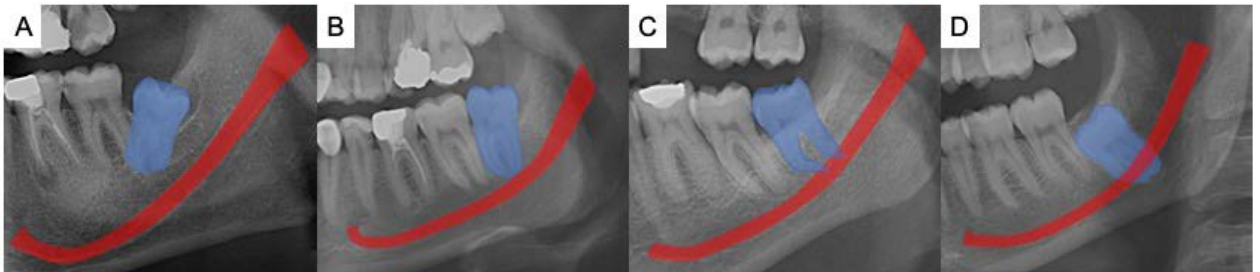
Figure 1. The examples for the classification of the relationship between the mandibular third molar (blue area) and mandibular canal (red area). ( A ) represents class I where there is no connection between the root tip and MC. ( B ) represents class II where the direct contact of M3 with the superior cortical boundary of the MC. ( C ) represents class III where the M3 and MC are superimposed and the ( D ) represents class IV where the root tip is under the inferior cortical line of MC.